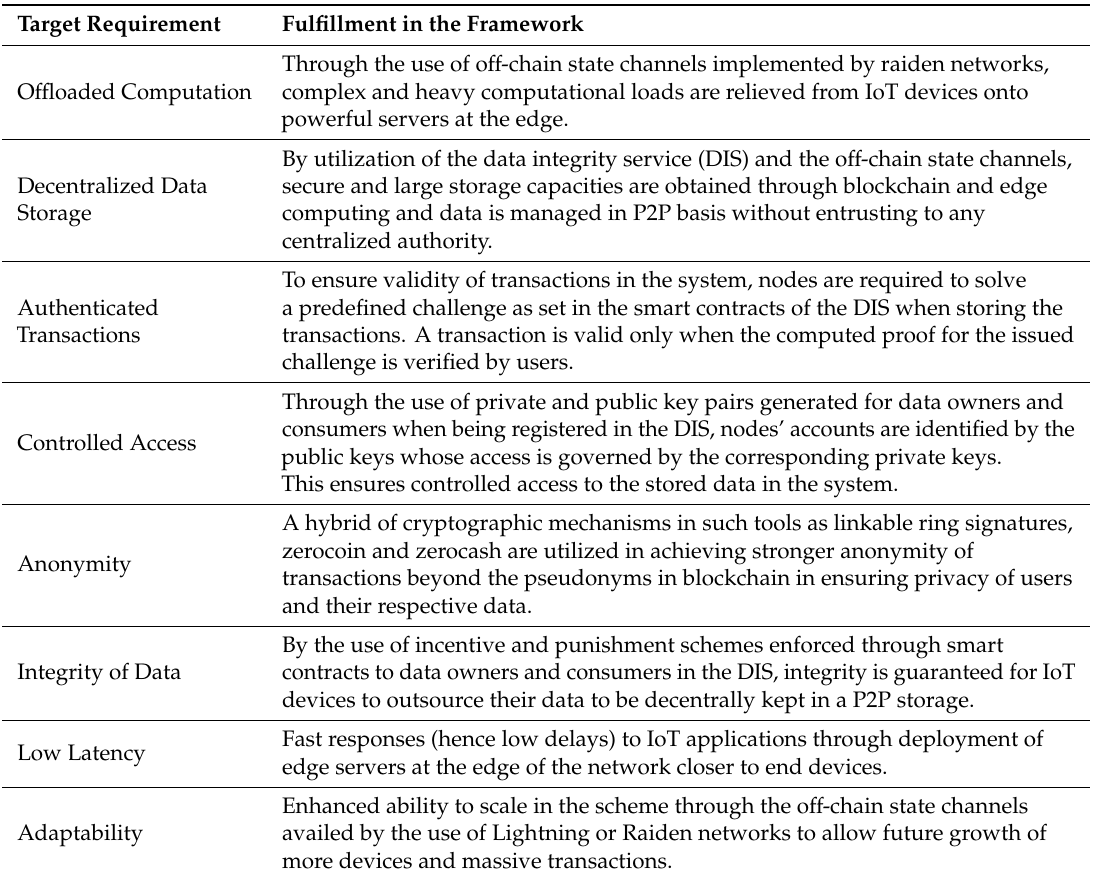
Table 1. Satisfaction of target design principles in the proposed